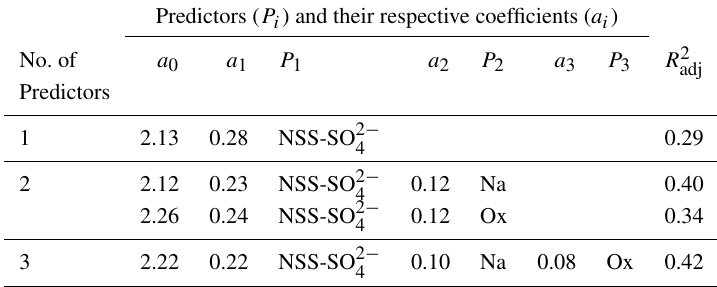
, Na, and Ox. 4 Predictors ( P i ) and their respective coefficients ( a i